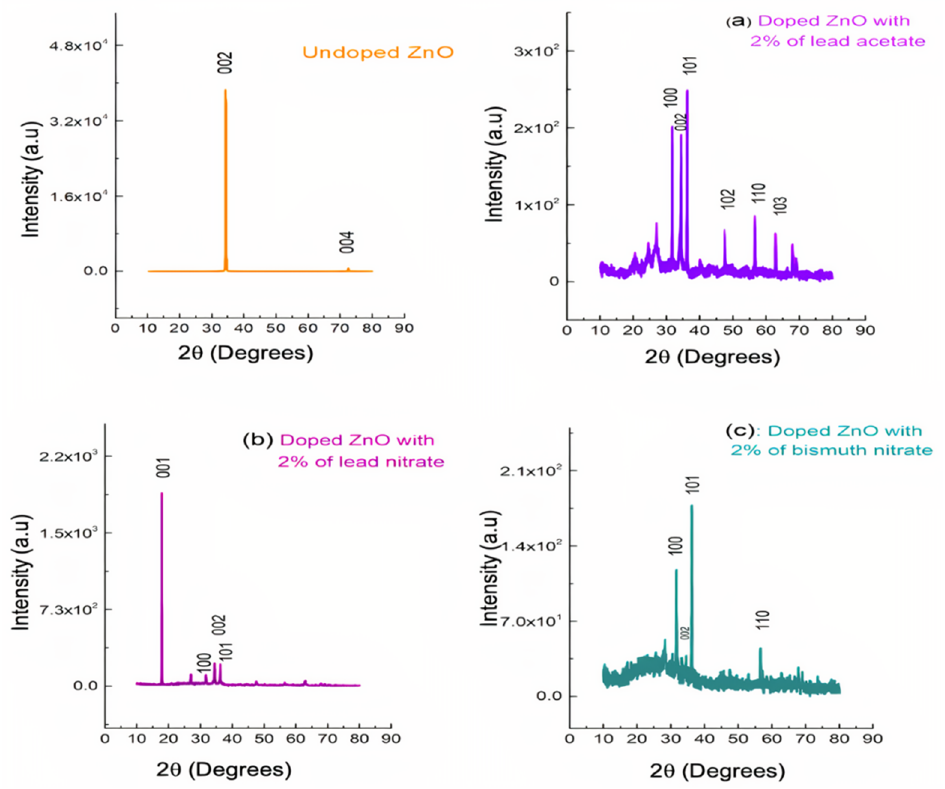
Figure 8. XRD patterns of undoped and doped ZONRs-TFs made with 2 wt.% of ( a ) LA, ( b ), LN, and ( c ) BN. Table 3. Grain sizes of undoped and LA-, LN-, and BN-doped (2 wt.%) ZONRs-TFs.